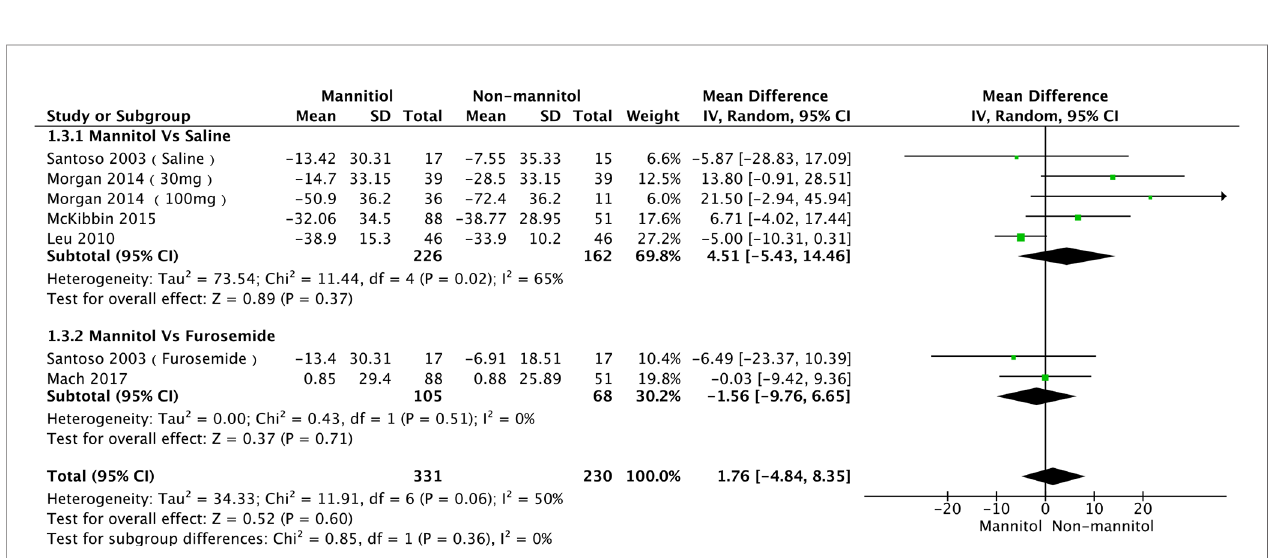
FIGURE 6 | Forest plot of mean difference (MD) for Creatinine Clearance